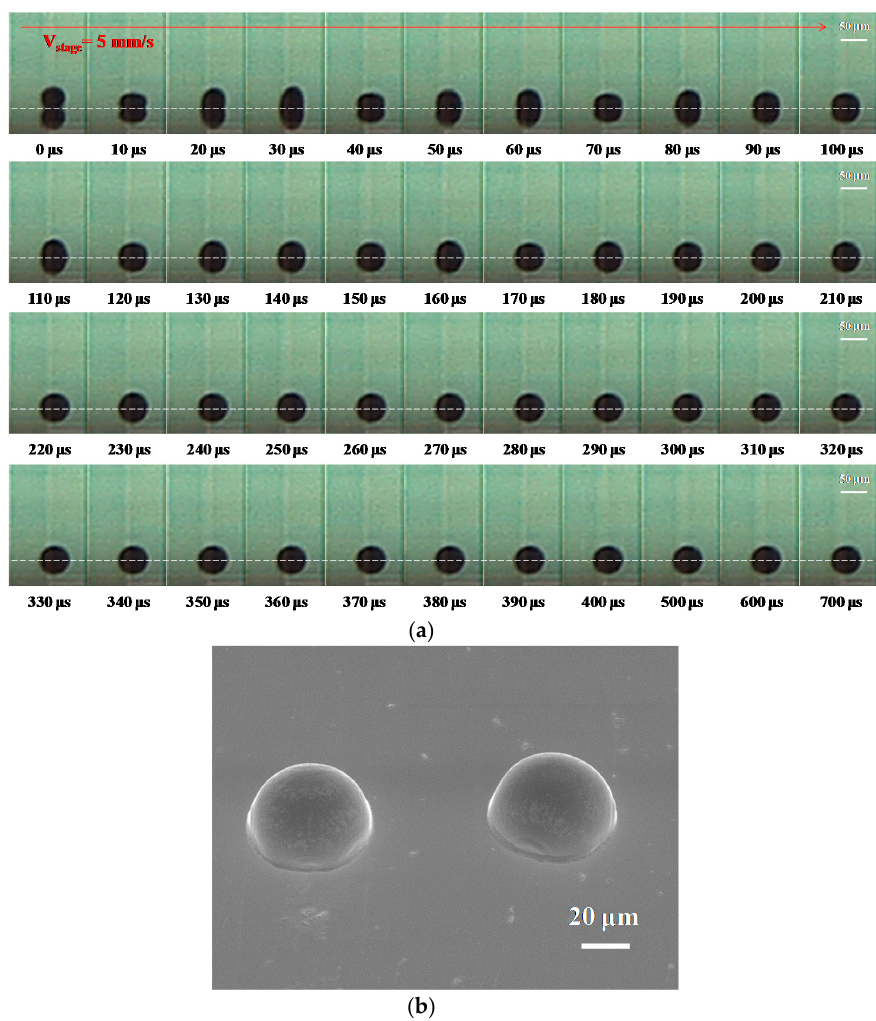
Figure 5. The deposition of a molten metal droplet under a dot spacing of 100 μ m with the following initial characteristics: diameter D 0 = 50 μ m, velocity = 1.1 m ∙ s − 1 , stage velocity = 5 mm ∙ s − 1 (frequency = 50 Hz) and sample temperature 30 °C (Stefan number Ste = 0.722). ( a ) Evolution of a droplet impacting onto a gold-plated glass substrate recorded using a high-speed digital camera with condition A in Table 2. The dashed lines separate the outline of the droplet from that of its reflection on the substrate. The scale bars are 50 µ m; ( b ) tilted 40 ◦ SEM photograph of the droplet deposited on a gold-plated glass substrate. The scale bar is 20 μ m.